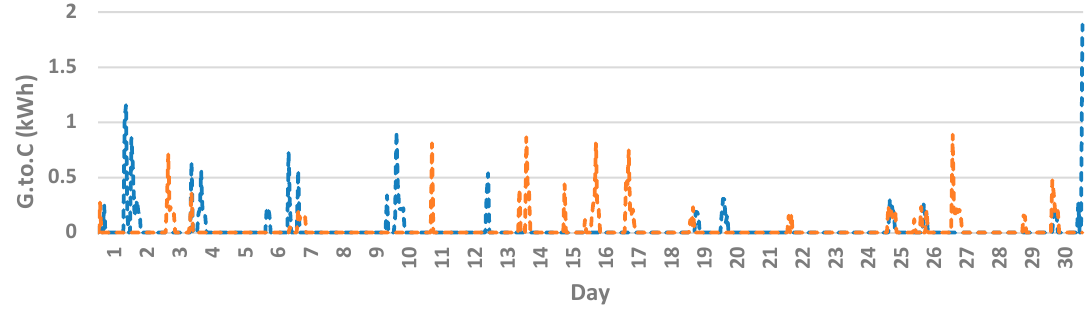
Figure 13. Energy transmission from grid to loads, for a single dwelling. Comparison between the most and least probable scenarios (blue and orange) for one month (April). Source: self-elaboration.